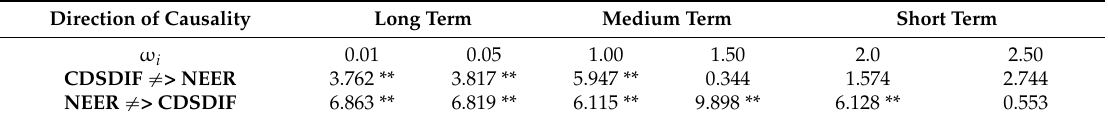
Table 4. Breitung and Candelon [26] frequency domain causality analysis results.